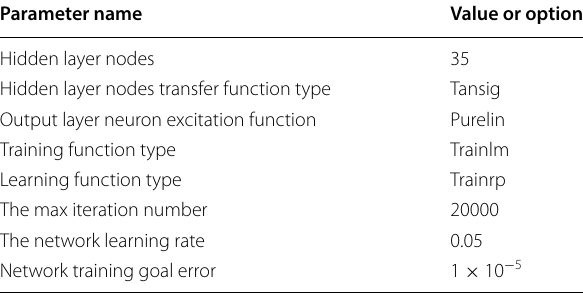
Table 1 BP neural network model